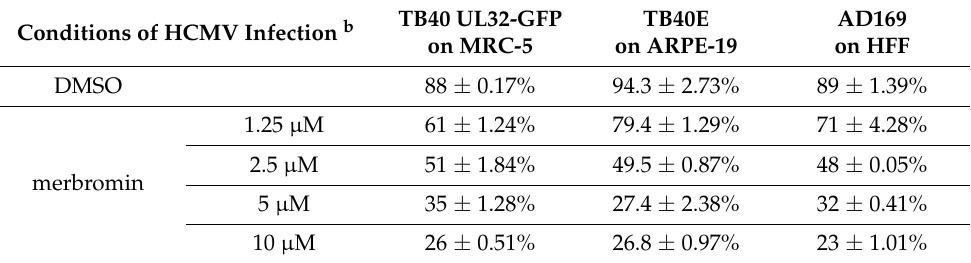
Table 1. Effect of merbromin on the formation of viral cytoplasmic assembly complexes (cVACs) a . Conditions of HCMV Infection